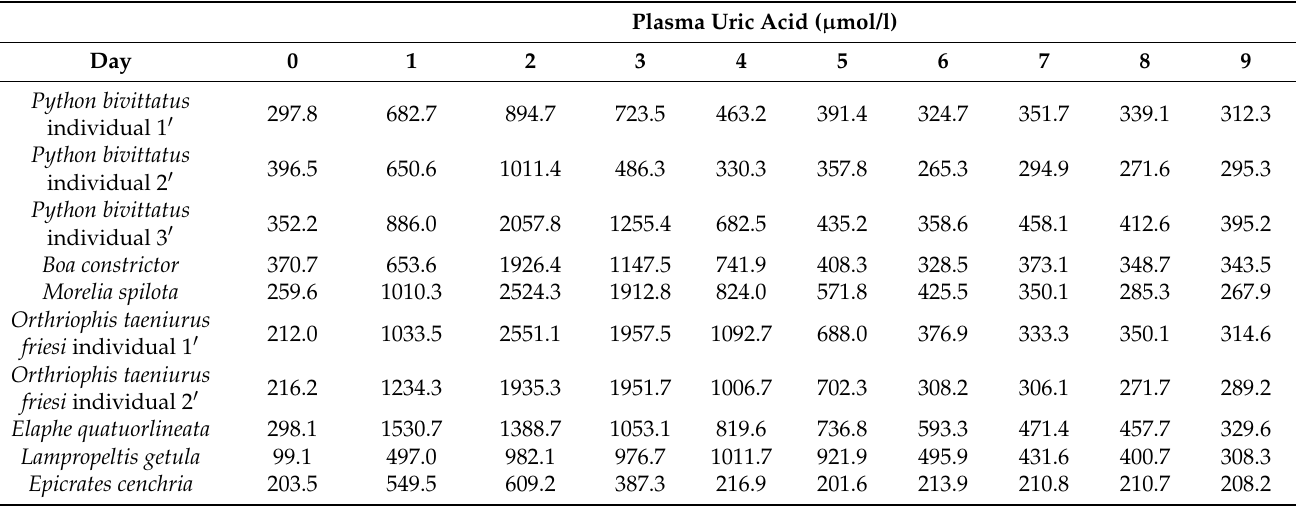
Table 3. Pre-feeding (day 0) and post-feeding (day 1–9) uric acid concentrations in snake plasma after meal 2.